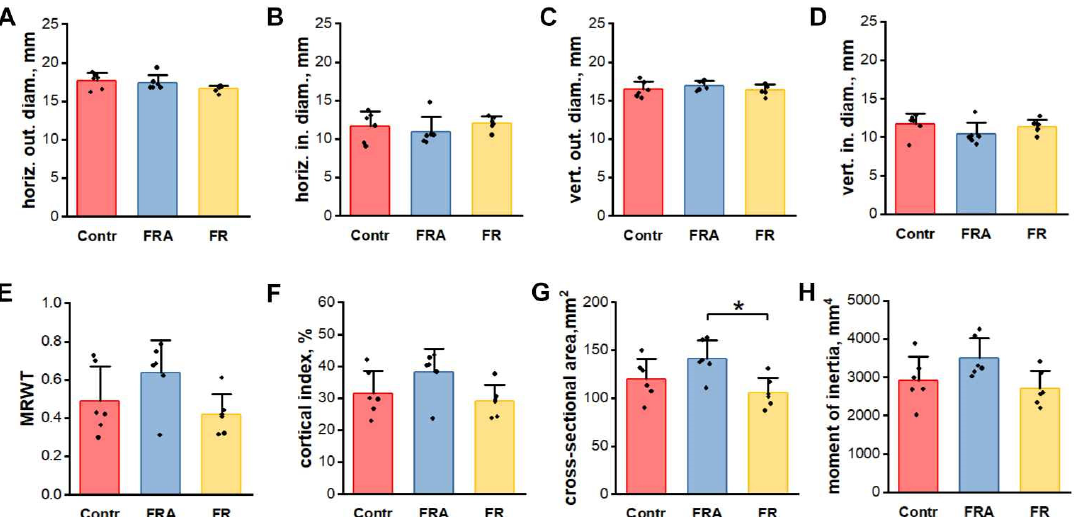
Figure 2. Geometrical properties of bone mid-diaphysis of femurs of animals in experimental groups. ( A ) horizontal external diameter, ( B ) horizontal internal diameter, ( C ) vertical external diameter, ( D ) vertical internal diameter, ( E ) mean relative wall thickness (MRWT), ( F ) cortical index, ( G ) cross-sectional area, ( H ) moment of inertia. Bar plots show mean values and standard errors. A range of p -values has been assigned above plots where two groups show significant differences: * p < 0.05.